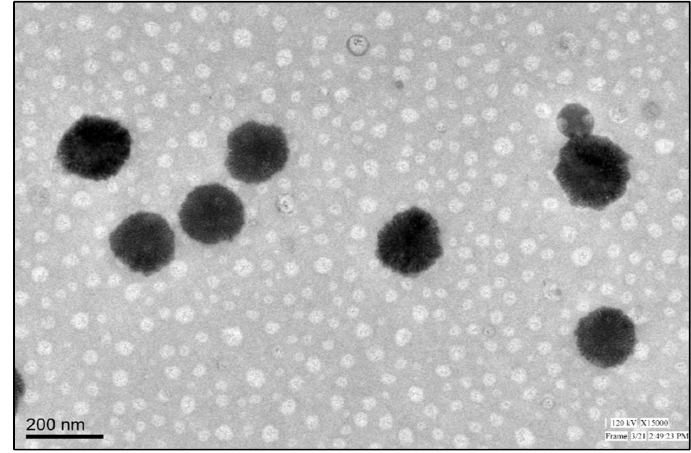
Figure 6. Surface morphology image of BF-NLCopt.